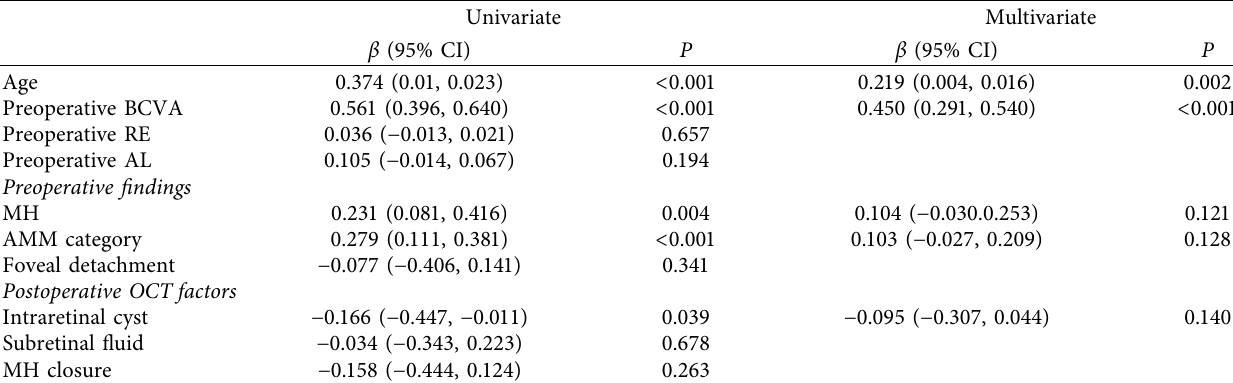
Figure 3: Presurgery and postsurgery OCT images of patients with postoperative intraretinal cysts. (a) Presurgery image showing foveoschisis with MD. (b) Image of intraretinal cyst at 21 months postsurgery. (c) Presurgery image of MH with MD. (d) Image of intraretinal cyst at 24 months postsurgery. MD � macular detachment, MH � macular hole, and OCT � optical coherence Table 5: Multiple linear regression analysis of preoperative and postoperative factors with visual acuity at 2y after surgery.